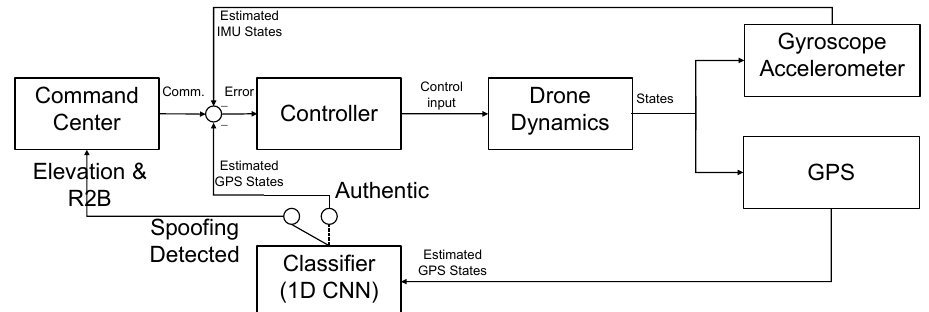
Figure 14. Feedback loop for the anti ‐ spoofing enabled drone.